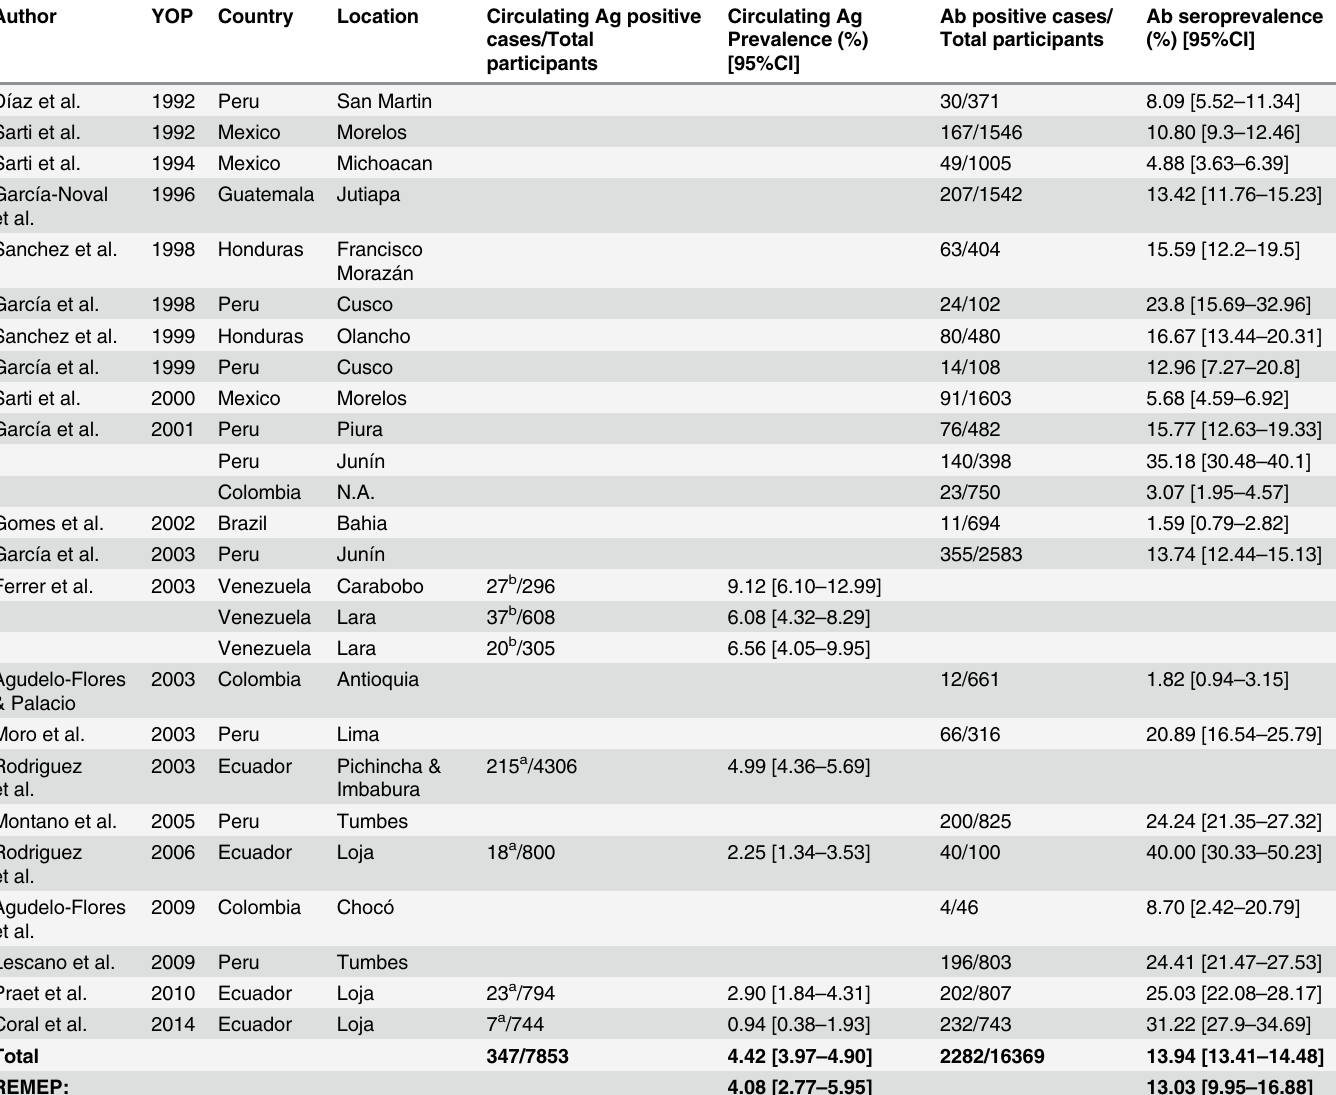
Table 2. Sero-epidemiological studies using Ag-ELISA and/or EITB for human cysticercosis in Latin